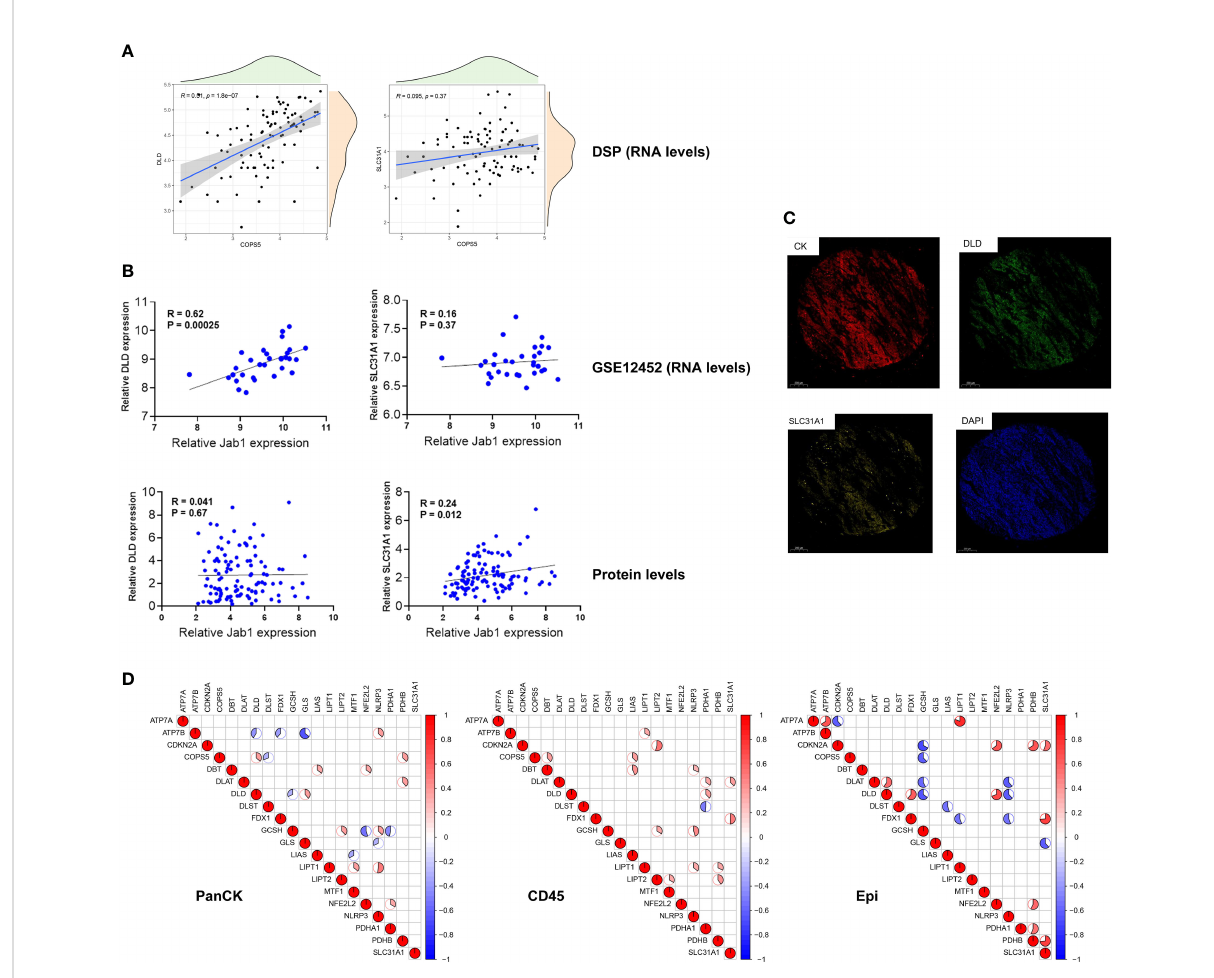
FIGURE 3 The relationship between cuproptosis related genes and Jab1 in NPC Correlation analysis of cuproptosis related genes and Jab1/COPS5 expressions in RNA (A, B) and protein levels (B, C) . (D) Correlation analysis of cuproptosis related genes and Jab1/COPS5 expressions in three regions (tumor cell-enriched region, immune cell-enriched region, and normal epithelial region). Red (positive correlation), blue (negative correlation), sector direction (clockwise for positive correlation, and counterclockwise for negative correlation), only the sector area at p < 0.05 is shown. The darker the colors, the larger the sector areas, and the higher the